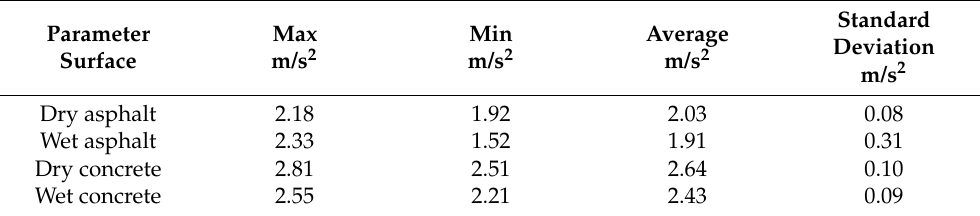
Table 4. Statistical characteristics of the acceleration values in the acceleration maneuvers of the urban bus.